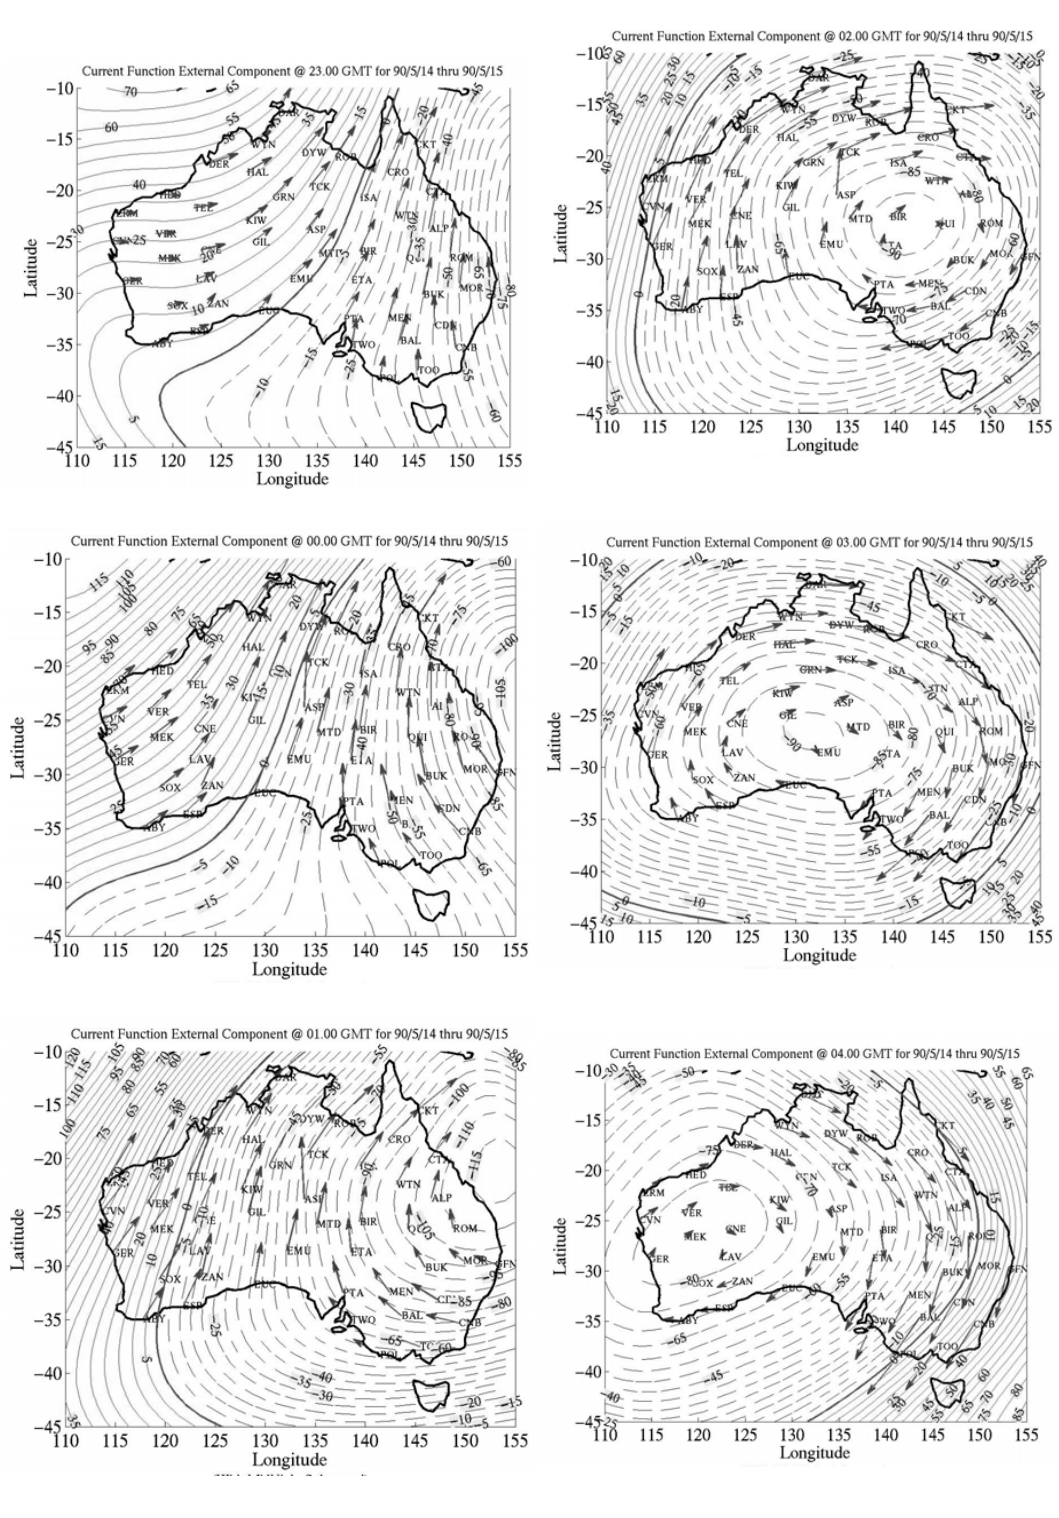
Fig. 9. Current systems on 15 May 1990, as for Fig. 3. The universal times of the plots range from 23.8h (labelled 23.00GMT) on 14 May to 5.8h (labelled 05.00GMT) on 15